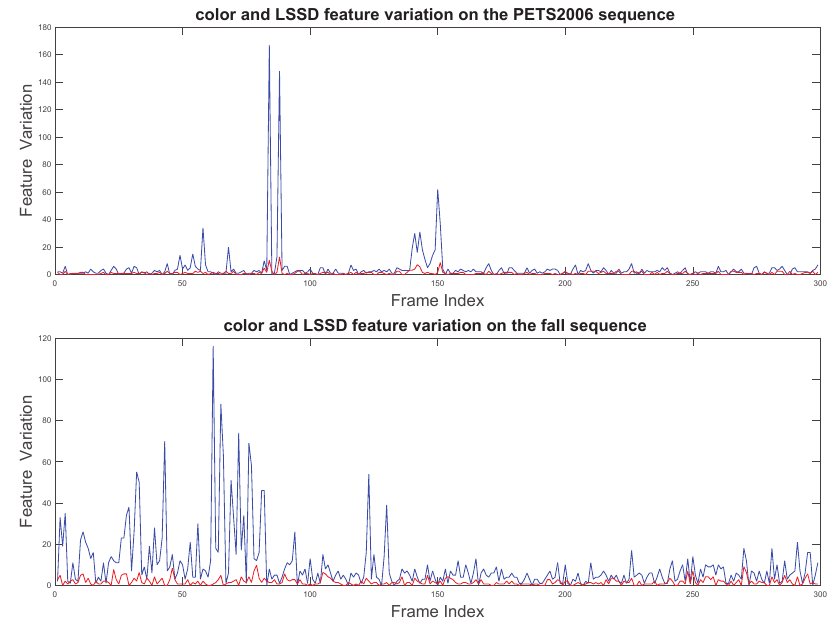
Figure 5. Color and LSSD (Local Similarity Statistical Descriptor) feature values variation of a pixel (the center of the small red box in Figures 3 and 4) from the first frame to the 300th frame of the PETS2006 and fall sequence. The blue line represents the color feature and the red line represents the LSSD feature.